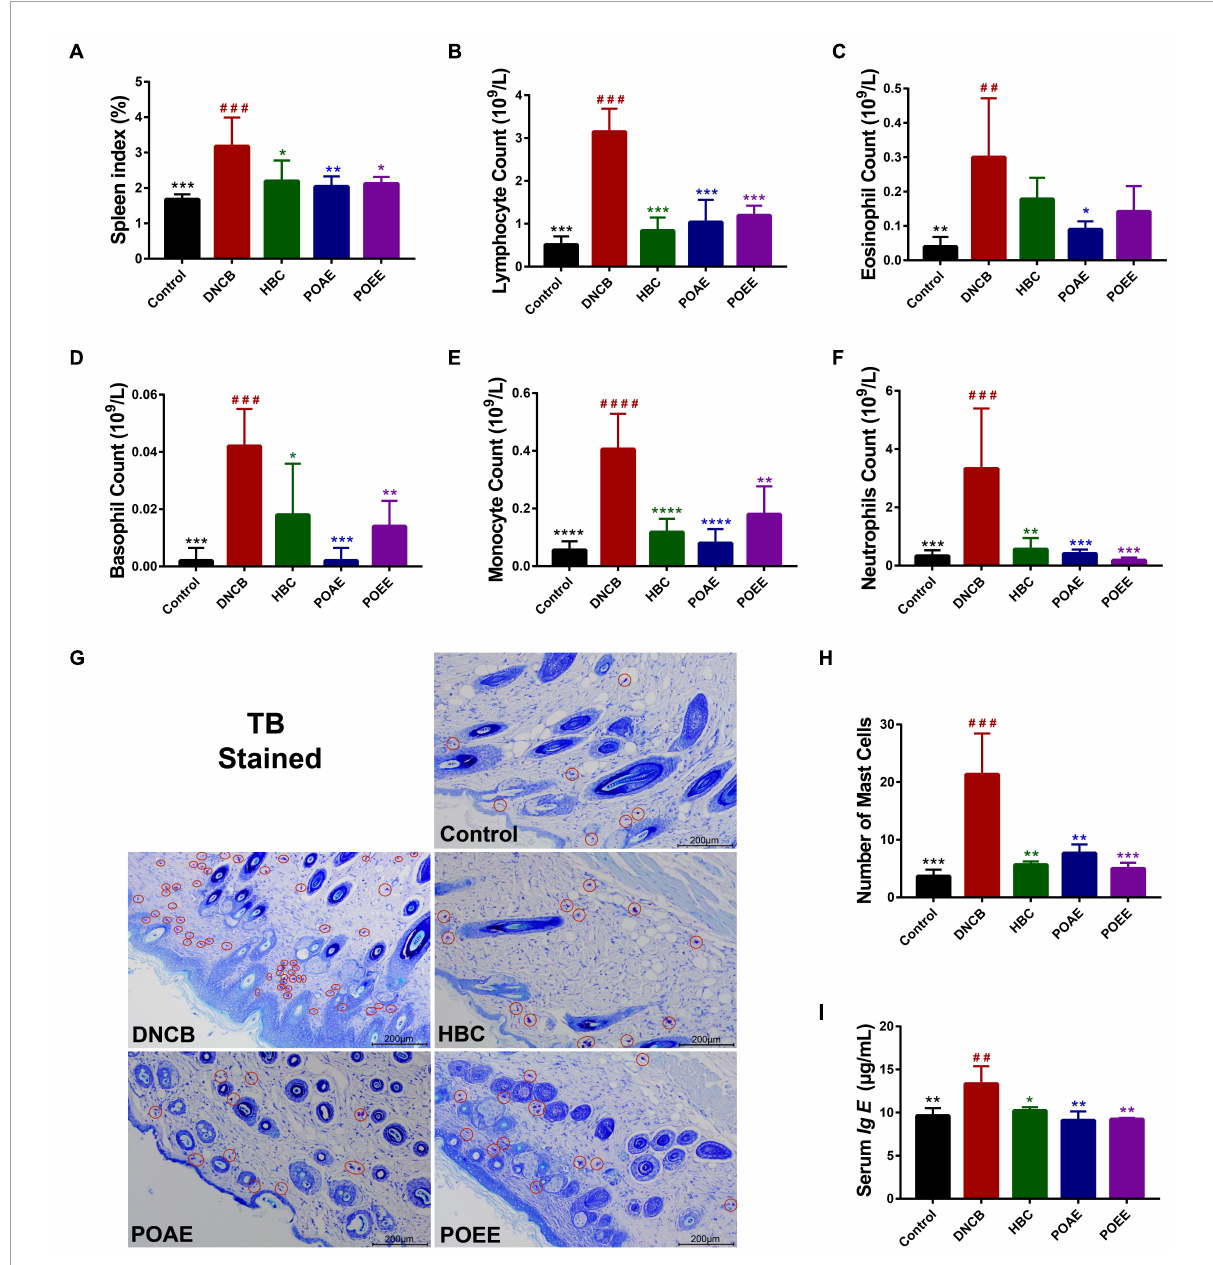
FIGURE4 POAE and POEE reduced the number of immune cells and abnormal increase in serum Ig E in AD mice. (A) Spleen indices of mice in each group ( n = 5 per group). (B–F) The number of lymphocytes, eosinophils, basophils, monocytes and neutrophils in each group of mice ( n = 5 per group). (G) Pictures of representative dorsal skin TB staining of each group. Red circles mark some of the mast cells (Scale bar: 200 µ m). (H) The number of mast cells in the dermis of each group ( n = 3 per group). (I) Serum Ig E concentration of mice in each group ( n = 3 per group). The data were expressed as mean ± SD. ## P < 0.01, ### P < 0.001, #### P < 0.0001, vs. control groups; * P < 0.05, ** P < 0.01, *** P < 0.001, **** P < 0.0001, vs. model (DNCB)